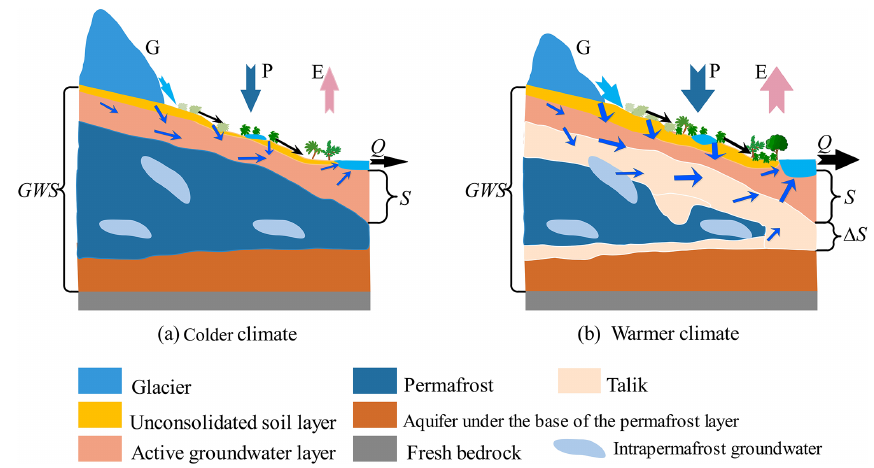
Figure 10. A schematic illustration of the climate warming effect on surface conditions and the subsurface profile and hydrological variables. The larger sizes of the arrows indicate a large increase in the hydrological variables, e.g., glacier melting, precipitation, discharge, and